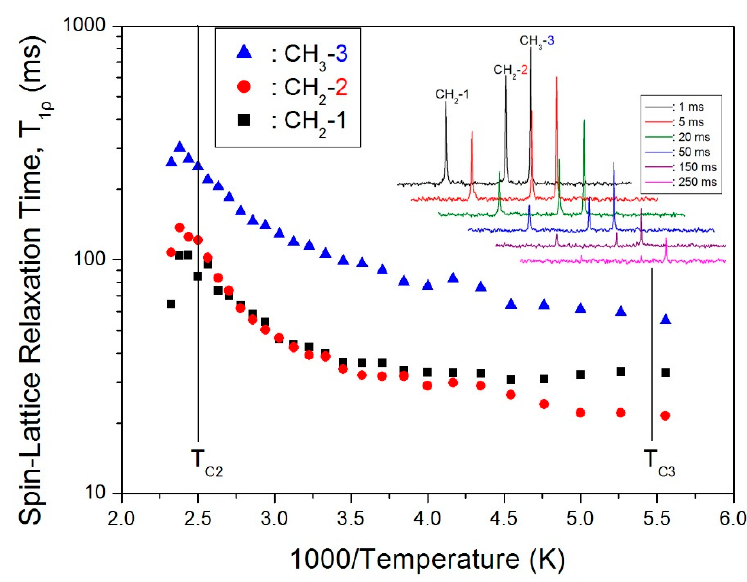
Figure 5. Spin–lattice relaxation times in the rotating frame T 1 ρ for each group of carbon in (CH 3 CH 2 CH 2 NH 3 ) 2 CdCl 4 vs. 1000/T. Inset: Recovery trace for each carbon at different delay times and 300 K.